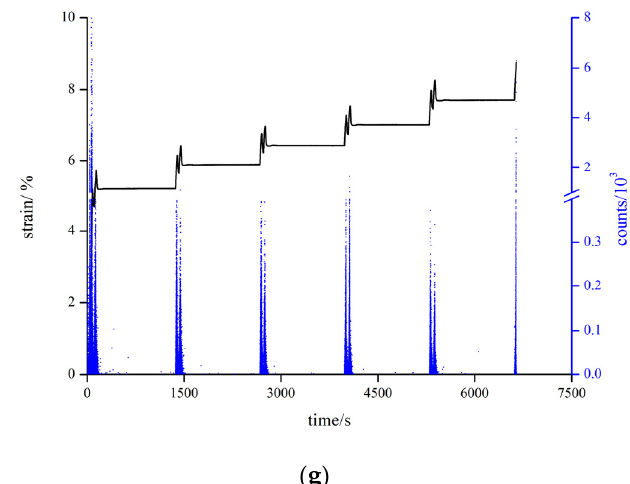
Figure 9. Features of AE counts for tests carried out with fatigue intervals of ( a ) 5 s, ( b ) 10 s, ( c ) 60 s, ( d ) 120 s, ( e ) 600 s, ( f ) 900 s, and ( g ) 1200 s.